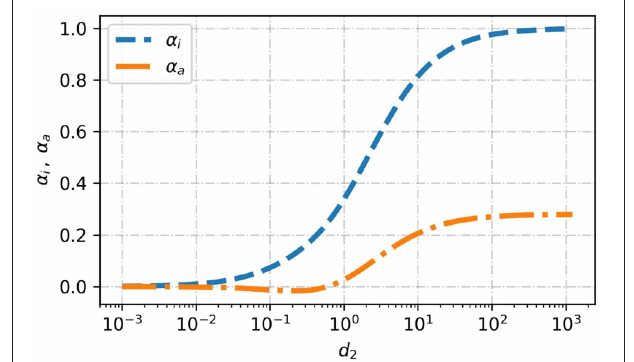
FIGURE 3 | The decay profile Z ( r ; d ) next to the particle surface r = 1 is plotted for different d ∈ { 0.1,0.6,1,8,20 } . d < 1 corresponds to a fast decay compared to the particle size and d > 1 corresponds to a slow decay.